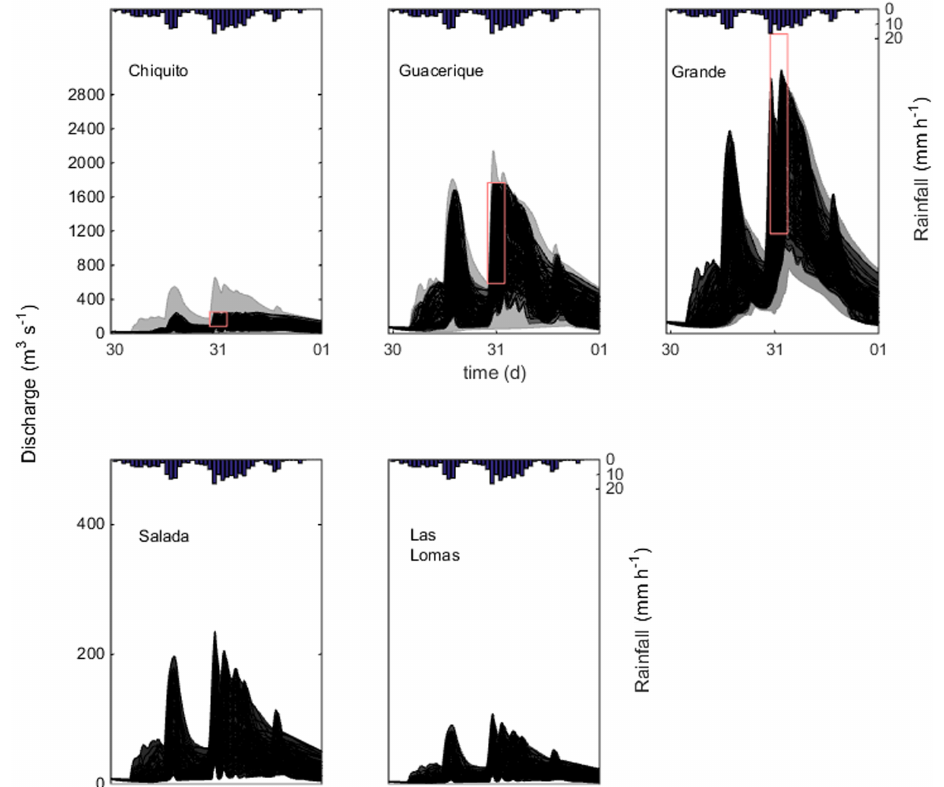
Figure 6. Precipitation (bars) and 100 class hydrographs chosen from the behavioural ones (black plots) for five sub-catchments upstream of the floodplain. Predictive range of the 100% probability limits for all hydrograph simulations (grey shaded area) and rectangles representing the fuzzy set to allow for uncertainty for peak discharge and time of the peak for the sub-catchments of the Chiquito, Guacerique, and Grande